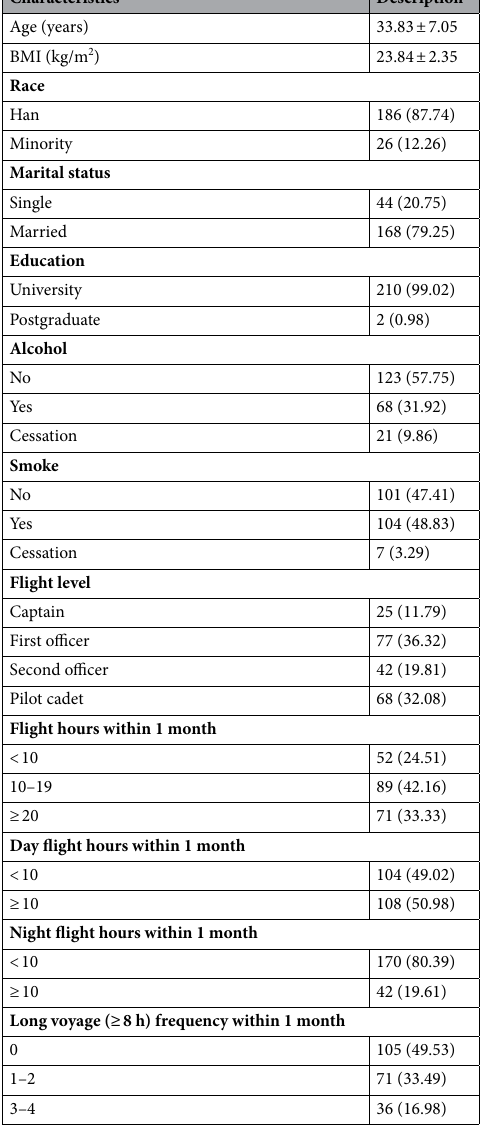
Table 1. Demographic characteristic of the study participants. Continuous variables were expressed by mean ± standard deviation and categorical variables were expressed by numbers